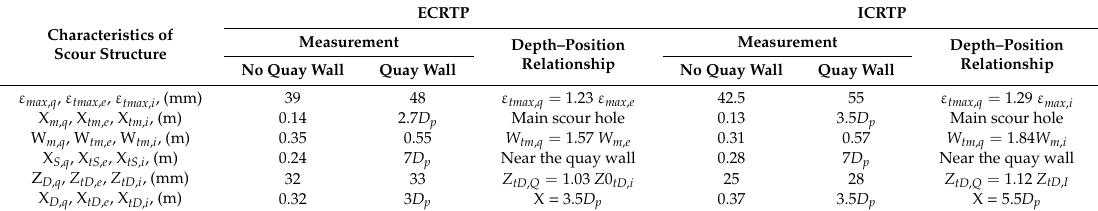
Table 6. Comparison of scour structures of external and internal rotating propellers at 7 D p away from quay